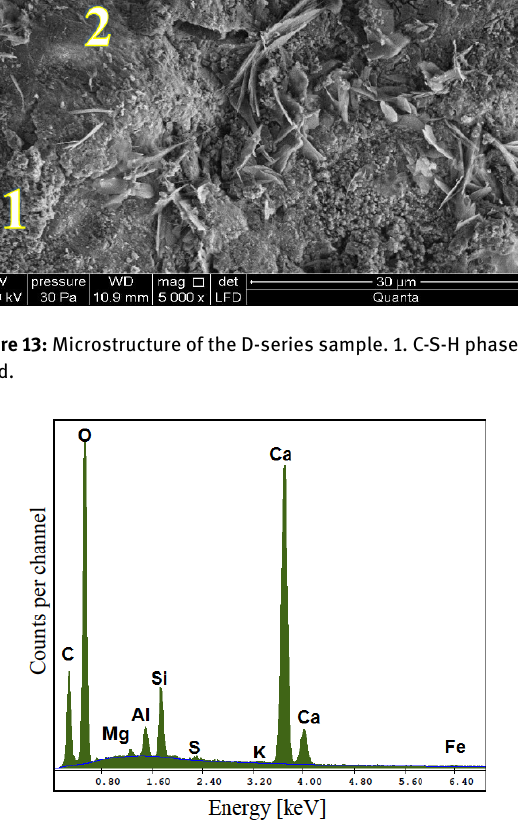
Figure 14: EDS analysis. 1.